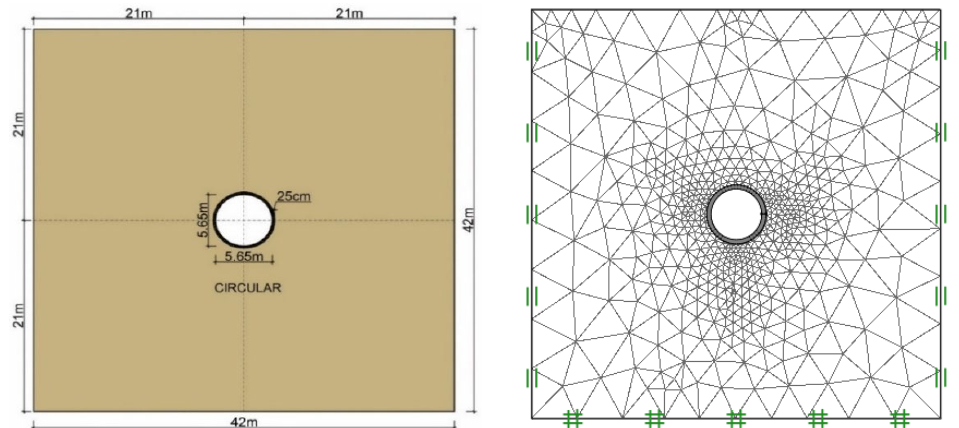
Figure 8. Schematic diagram of tunnel box used for the full-scale numerical study.